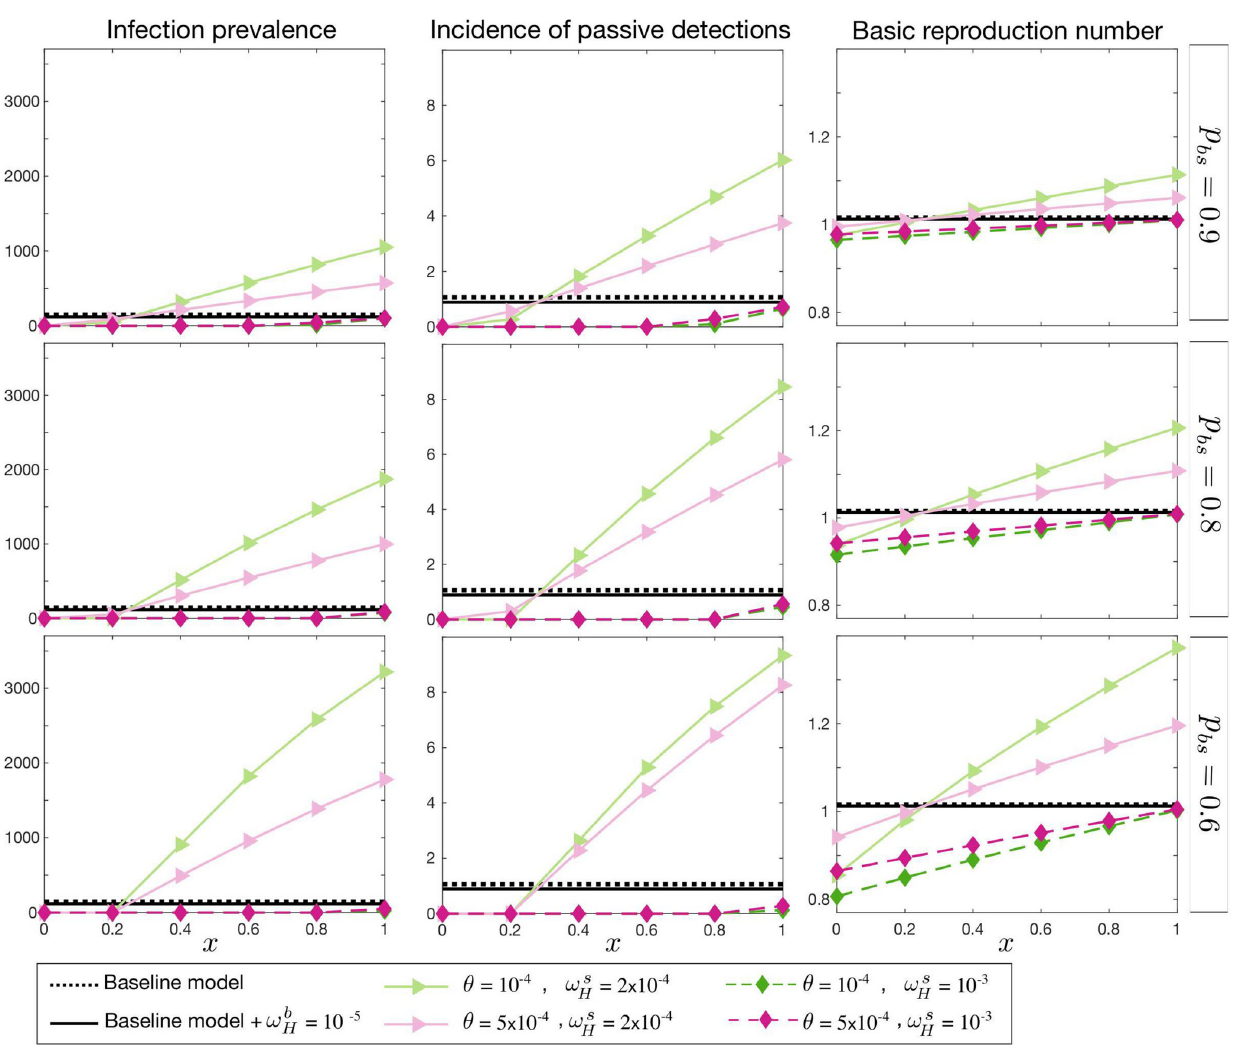
Fig 5. Endemic equilibrium with fixed effective tsetse density, m eff . Total prevalence, I H , observable incidence, u γ H ( Y ) I 2 H , and the basic reproduction number, R 0 , are plotted as a function of x , the relative infectiousness of skin-only infections compared to blood infections. The proportion of blood to skin- only infections, p bs , is fixed for each row and different values of the self-curing skin-only infection rate, o s rate, θ , are shown with various colours. There is no skin-only infection, p asymptomatic components) and the solid line represents the baseline model but with the possibility of self cure from first-stage blood infection, I b o b ¼ 10 (cid:0) 5 . The prevalence and incidence are given per 10,000 people. H